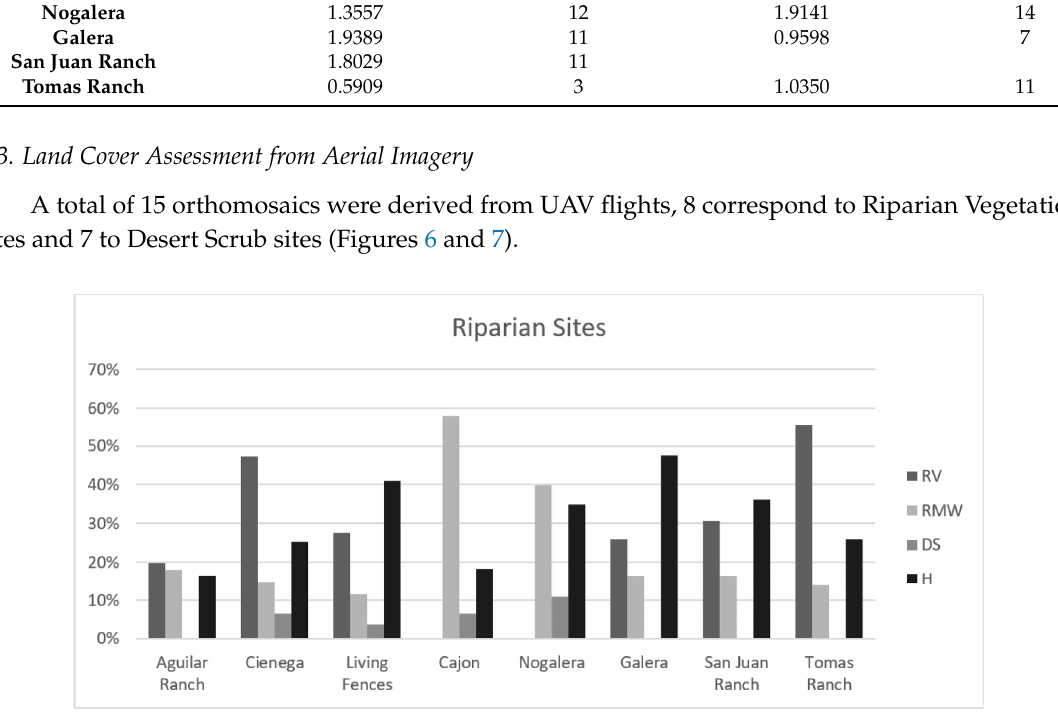
Figure 6. Cover percentage for Land Cover Classes for each site, derived from orthomosaics of Riparian sites. RV (Riparian Vegetation), RMW (Riparian Mesquite Woodland), DS (Desert Scrub), H (Herbaceous cover).